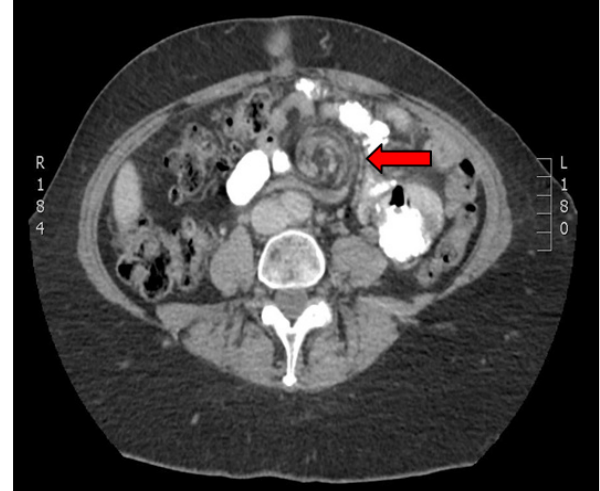
Image 1. Axial computed tomography of the abdomen shows “swirl sign” indicative of internal hernia (red